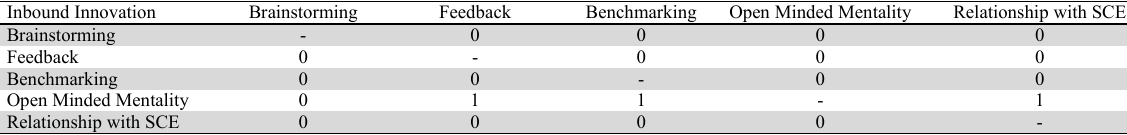
Discordance matrix for the criterion inbound innovation Inbound Innovation